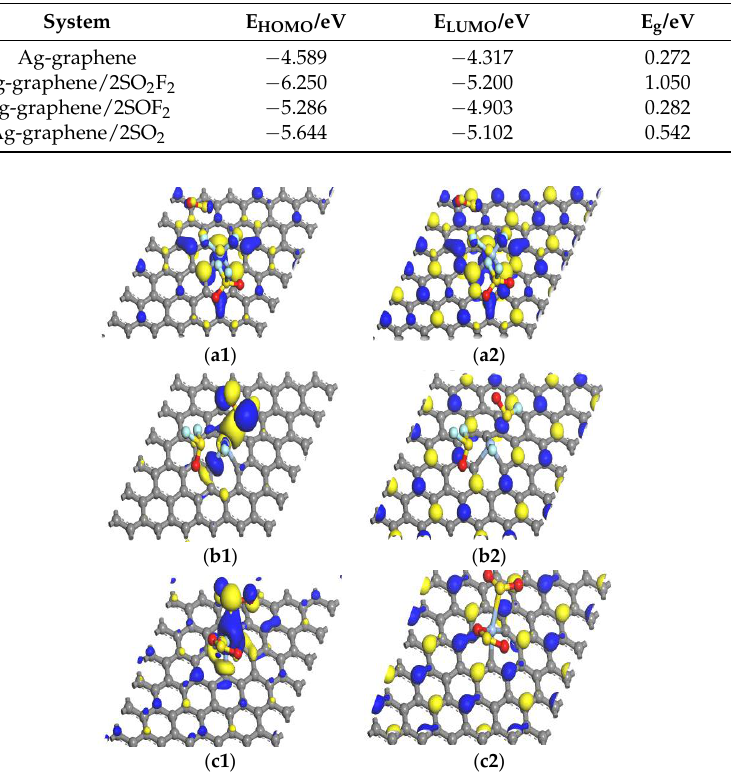
Table 6. Calculated HOMO, LUMO and HOMO-LUMO energy gap.